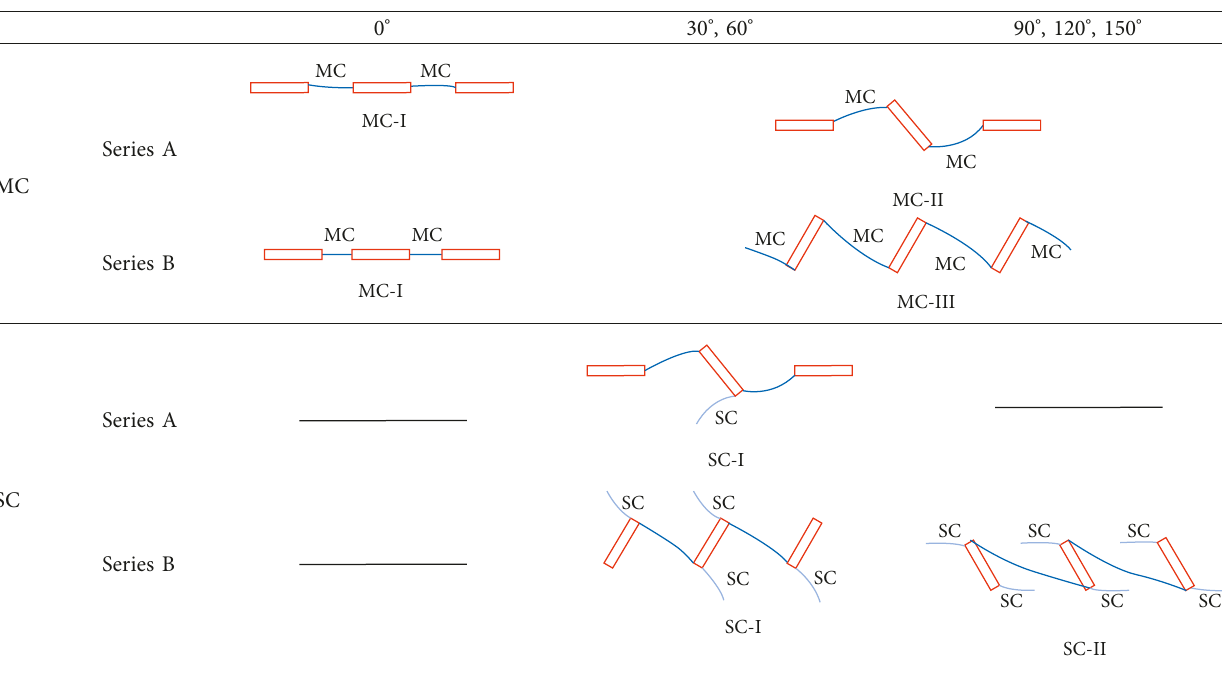
Table 4: Category of crack patterns.